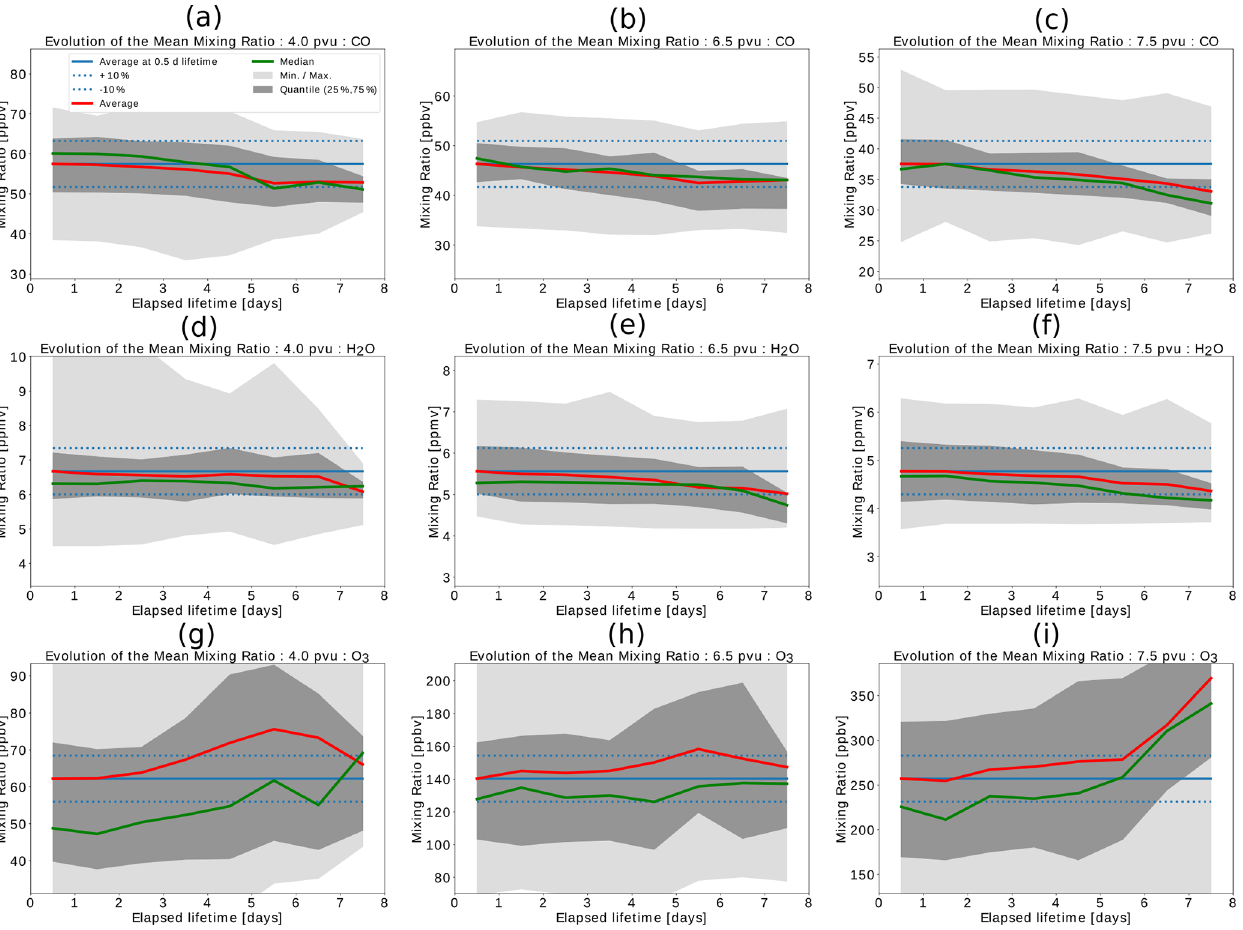
Figure 12. Mean evolution of CO (a–c) , H 2 O (d–f) , and O 3 (g–i) mixing ratios with respect to the 4.0PVU cutoffs (a, d, g) , 6.5PVU cutoffs (b, e, h) , and 7.5PVU cutoffs (c, f, i) . The mean evolution has been calculated by averaging over all cutoffs with a minimum lifetime of 3d from 2008 to 2018. The red line shows the mean value and the green line the median for every time step. Dark grey areas show the range between the upper and lower quantile, and the light grey areas show the minimum–maximum range. The blue solid lines indicate the average at day 0.5 and the dotted blue lines the ± 10% range from this